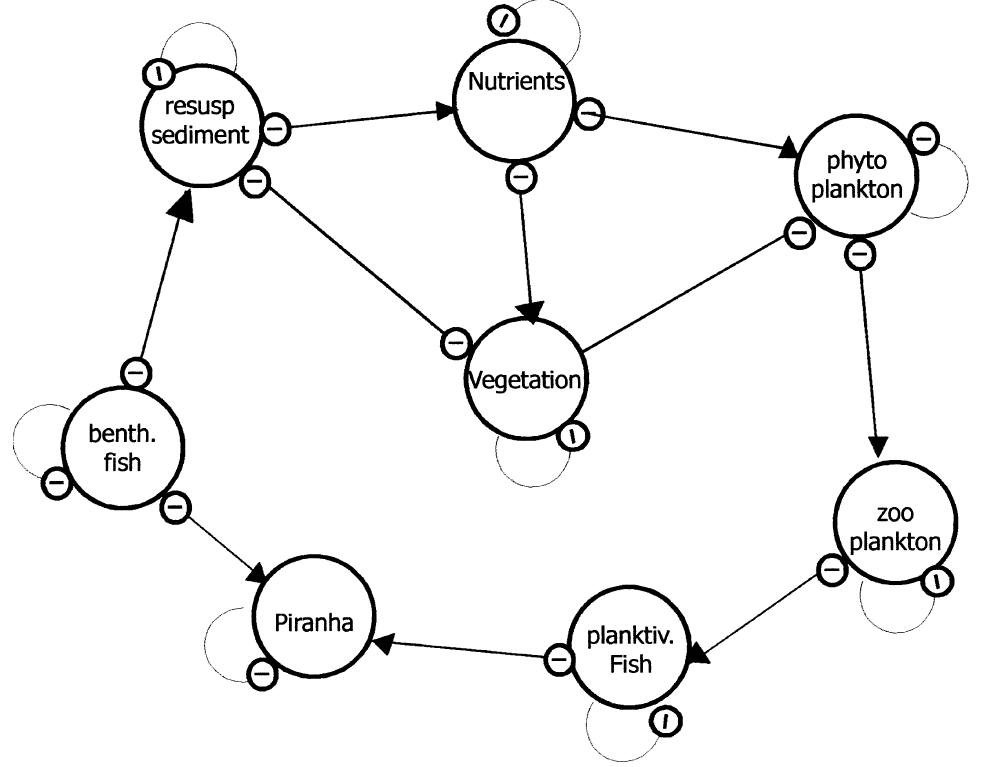
Fig. 2. Loop model of biotic and abiotic variables which could be impacted by economic activities in the Esteros del Ibera wetland lagoons. These variables are: nutrients (considered those that would effect vegetation growth), aquatic macrophytes (rooted emergent and submersed aquatic vegetation), phytoplankton, resuspension of lagoon sediment (consisting of fine organic material), zooplank- ton, small planktivorous fish, piranha and benthivorous